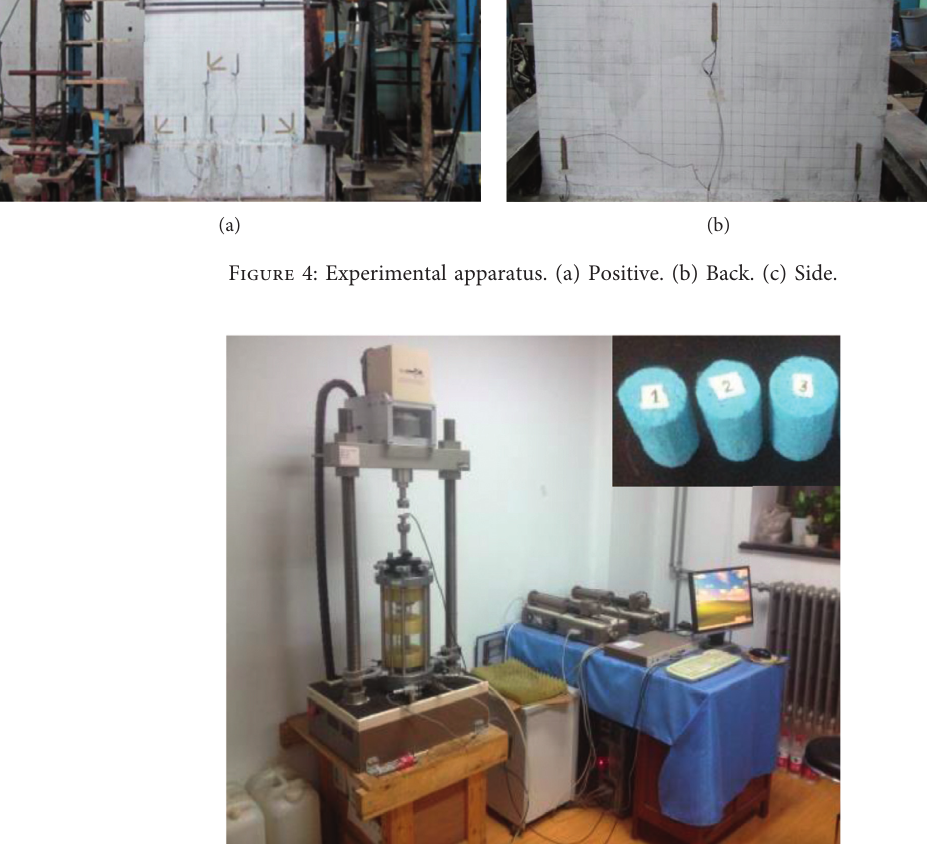
Figure 5: On-site experimental loading instrument.